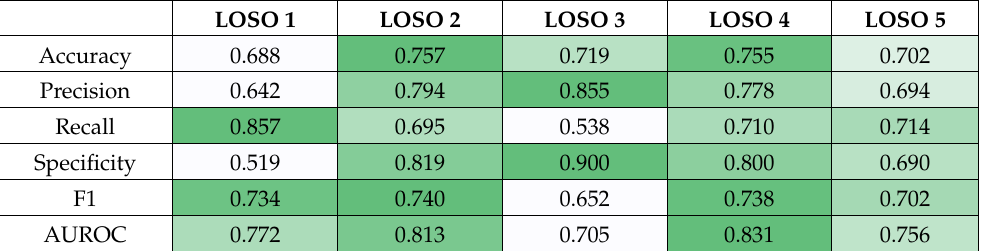
Figure 4. Gradient-weighted class activations mapping overlays for the initial ShrapML model. Representative images are shown with and without GradCAM overlays in a confusion matrix layout along with the prediction confidence.